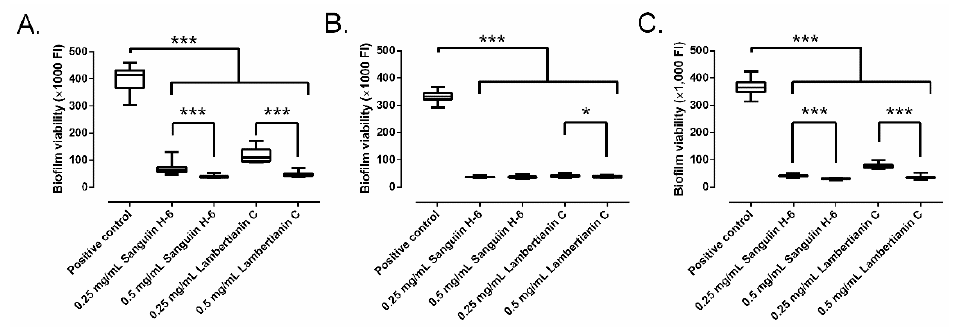
Figure 5. Biofilm development of SAP231 ( A ), MRSA1 ( B ), and MRSA2 ( C ) in presence of sanguiin H-6 and lambertianin C at different concentration:. *: p -value < 0.05, ***: p -value < 0.001 for Wilcoxon test.